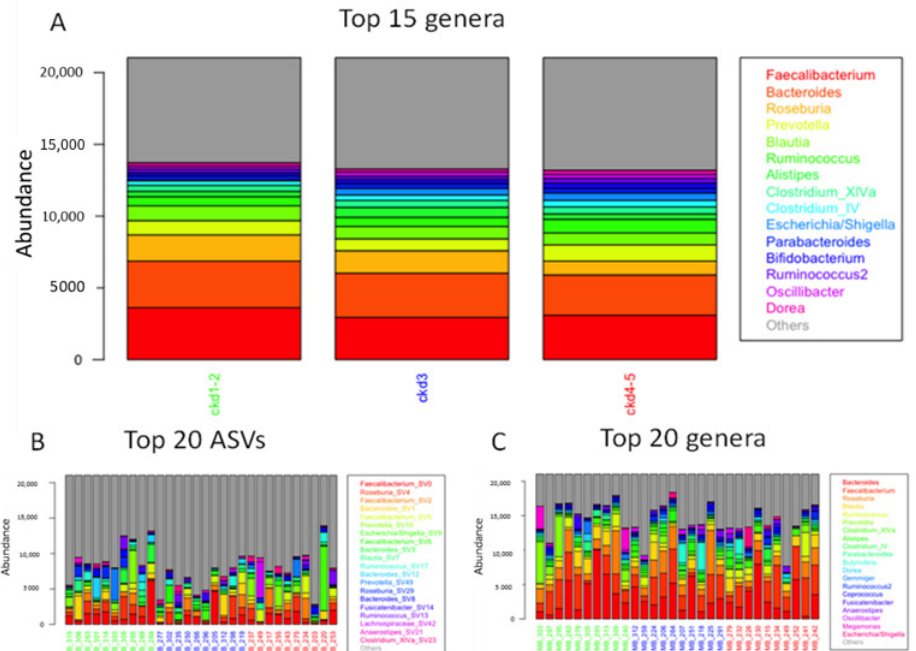
Figure 1. Mean abundance of the top genera or ASVs computed across all CKD stage-specific samples. ( A ) mean abundance of the top 15 genera in the different CKD stage groups; ( B ) mean abundance of the top 20 ASVs in 10 randomly selected samples per CKD stage group; ( C ) mean abundance of the top 20 genera in 10 randomly selected samples per CKD stage group. CKD: chronic kidney disease; ASV: 16S rRNA amplicon sequence variant.